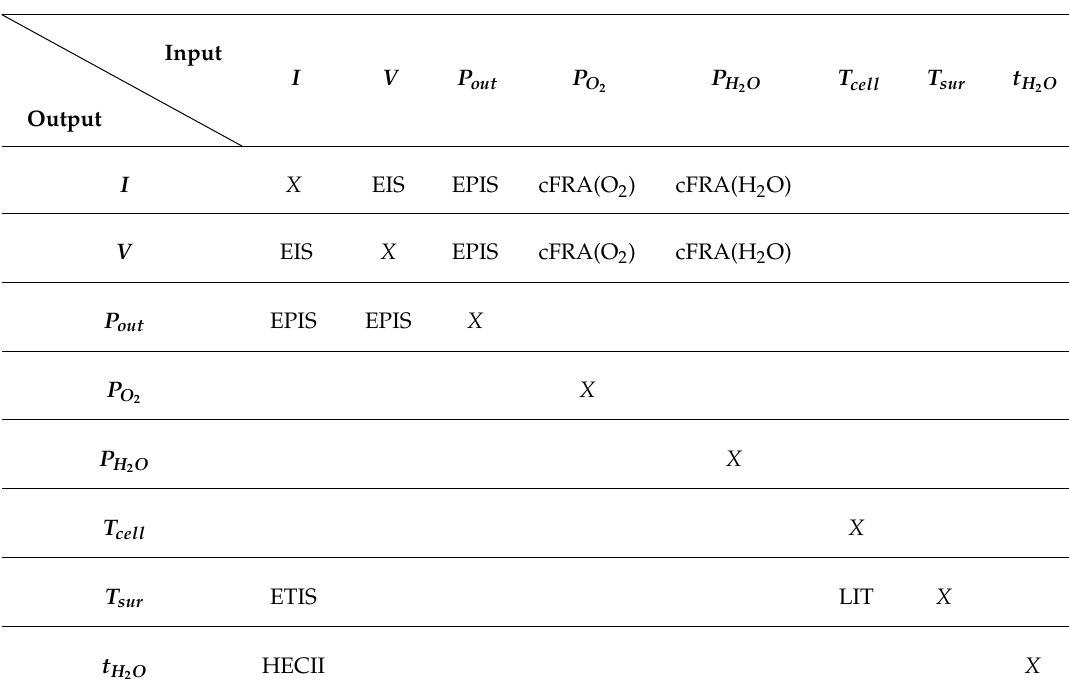
Table 2. An overview of input/output combinations applied in PEMFC research and corresponding frequency response